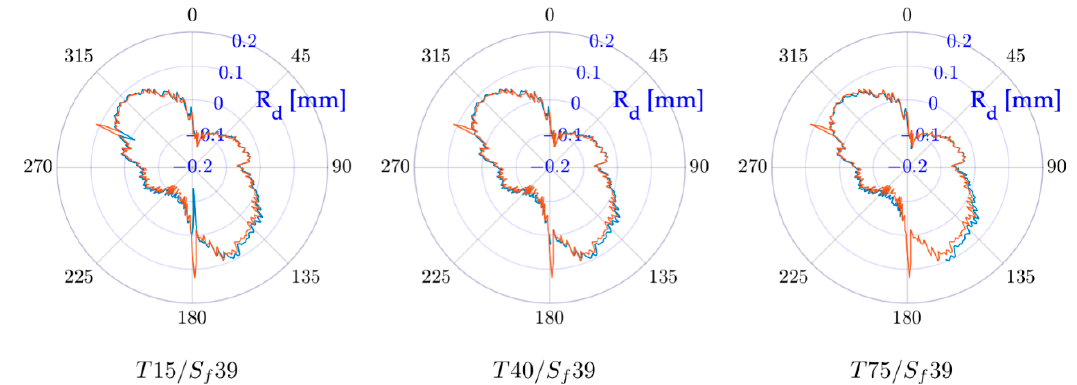
Figure 11. Polar graphs of R d calculated for S 02 including reference CMM data (red dots) and three different test conditions (blue dots).